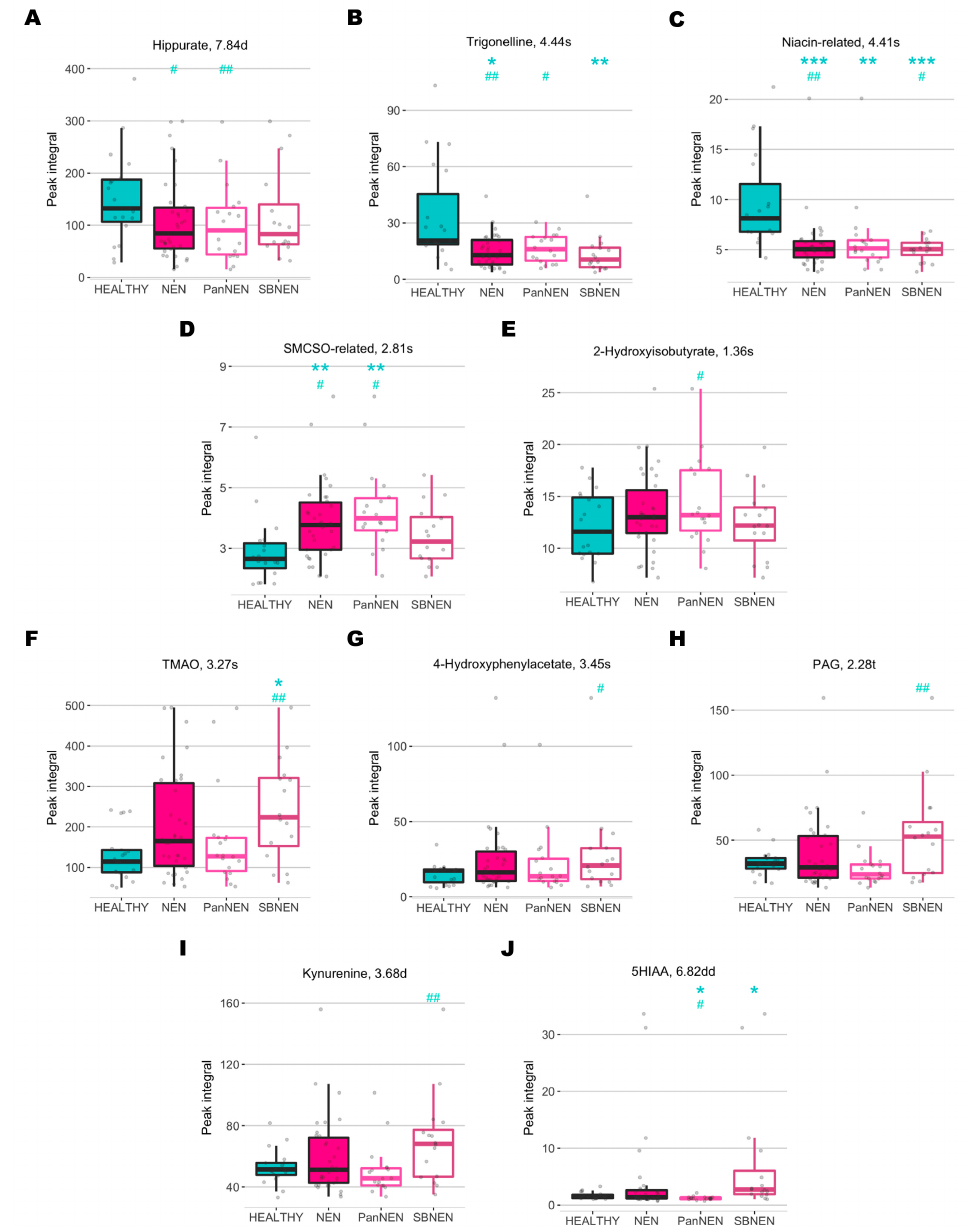
Figure 4. Boxplot of metabolites with significant differences between NEN and NEN subgroups compared to healthy control: ( A ) Hippurate, ( B ) Trigonelline, ( C ) metabolite related to niacin, ( D ) S-methyl-L-cysteine sulfoxide, SMCSO, related metabolite, ( E ) 2-Hydroxybutyrate, ( F ) Trimethylamine N-oxide, TMAO, ( G ) 4-Hydroxyphenylacetate, ( H ) Phenylacetylglu- tamine, PAG, ( I ) Kynurenine, ( J ) 5-Hydroxyindoleacetic acid, 5HIAA. Numbers in the title correspond to the chemical shift in ppm of the metabolite signal used for integration and the letters describe the signal multiplicity: singlet, s, doublet, d, doublet, dd, triplet, t The symbols * and # indicate the levels of significance compared to healthy control based on Wilcoxon’s rank sum test (*) and OPLS-DA model correlation (#), respectively: * and # for p FDR < 0.05; ** and ## for p FDR < 0.01; *** for p FDR <